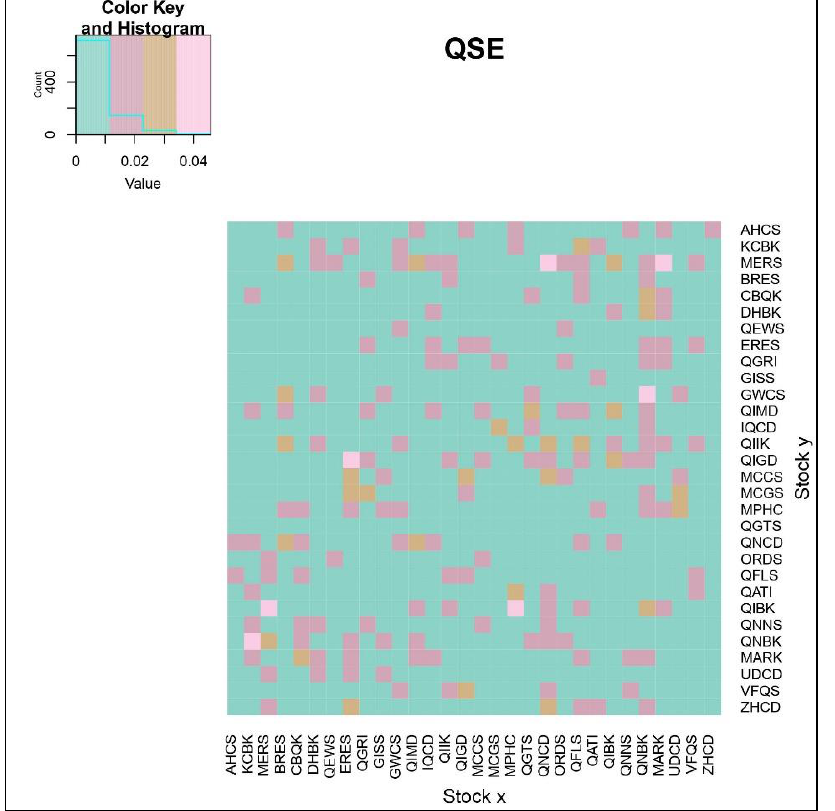
Figure 16. The information flow (effective transfer entropy) from stock y to stock x, for the top companies (by market capitalization) in the QSE market, after the COVID-19